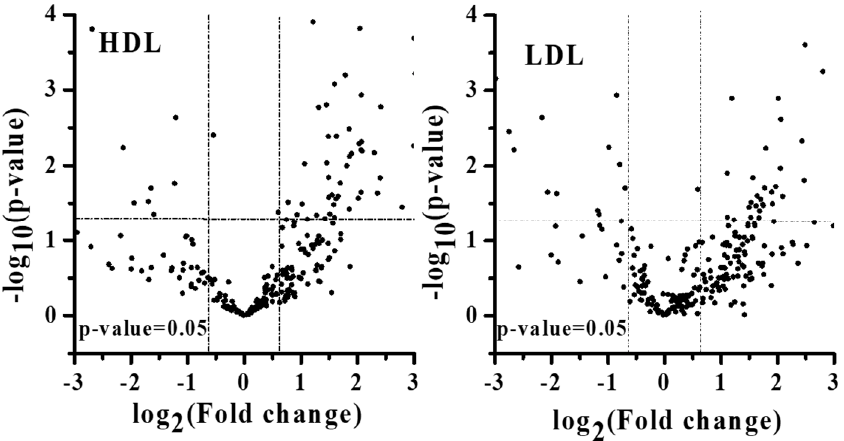
Figure 3. Volcano plots [-log 10 ( p -value) vs. log 2 (fold change)] of quantified lipids ( a ) HDL and ( b ) LDL fractions. Fold change represents the ratio of the patient group to control.